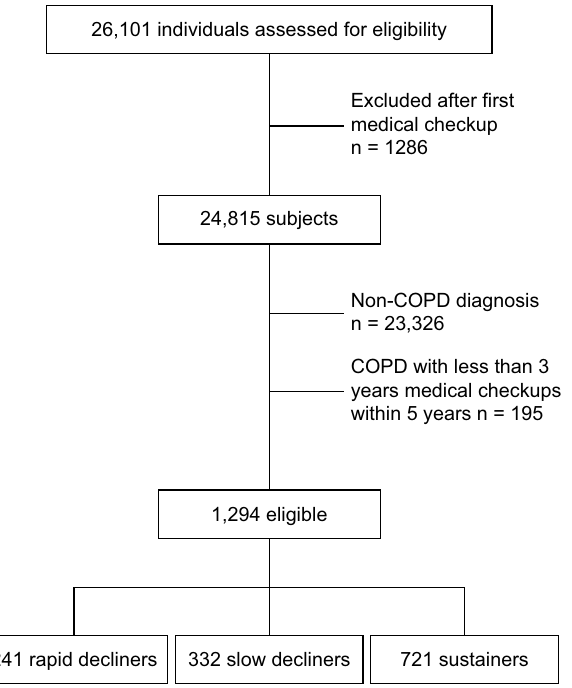
Figure 2. Patient